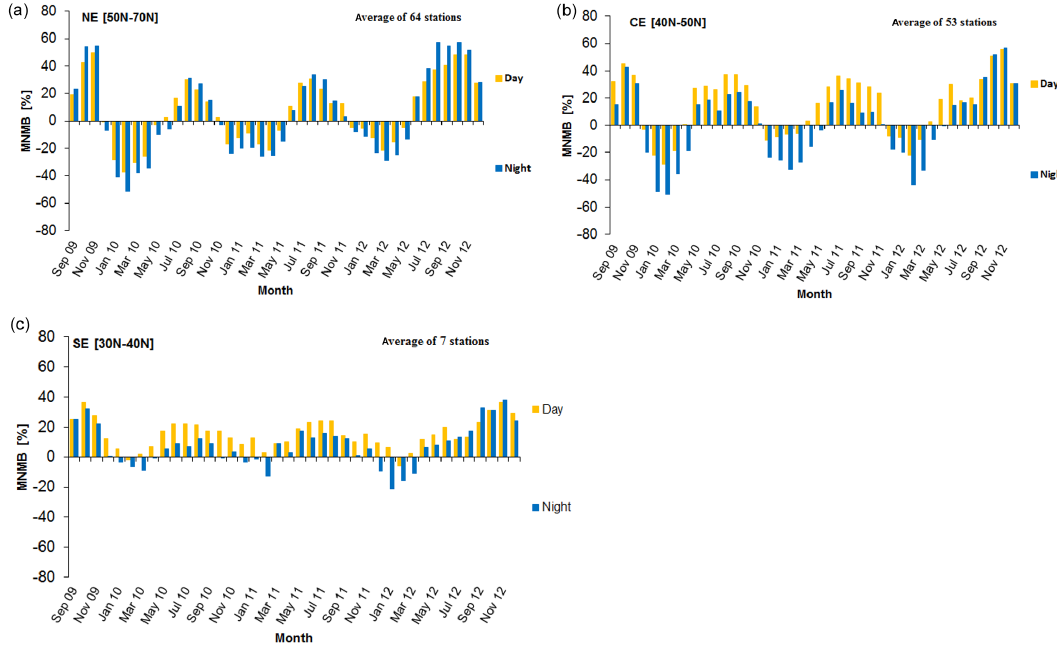
Figure 8. Modified normalised mean biases (MNMBs in %) derived from the evaluation of the MACC_osuite with EMEP O 3 surface obser- vations during daytime (yellow colour), and night-time (blue colour) over northern Europe (a) , central Europe (b) and southern Europe (c) during the period September 2009 to December 2012.